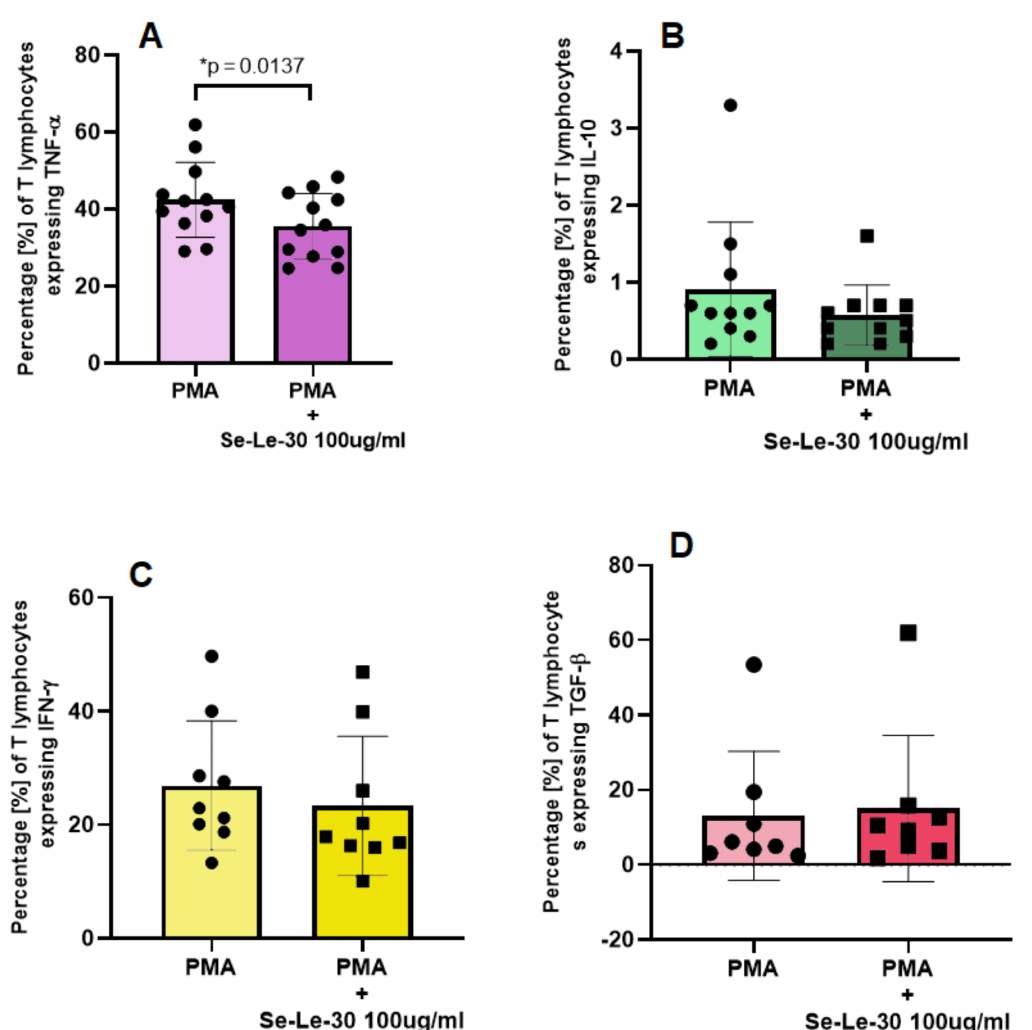
Figure 4. The effects of Se-Le-30 (100 µ g/mL) on the percentage of CD3+ T lymphocytes producing tumor necrosis factor (TNF)- α ( A ), interleukin (IL)-10 ( B ), interferon (IFN)- γ ( C ), and transforming growth factor (TGF)- β ( D ). Statistical differences were considered when p < 0.05. The mean values ( n = 12 for TNF- α , n = 11 for IL-10, n = 9 for IFN- γ , and n = 8 for TGF- β ) and standard deviations are given. * p < 0.05 vs. control. For a detailed explanation of the gating strategy, please see Supplementary Figure